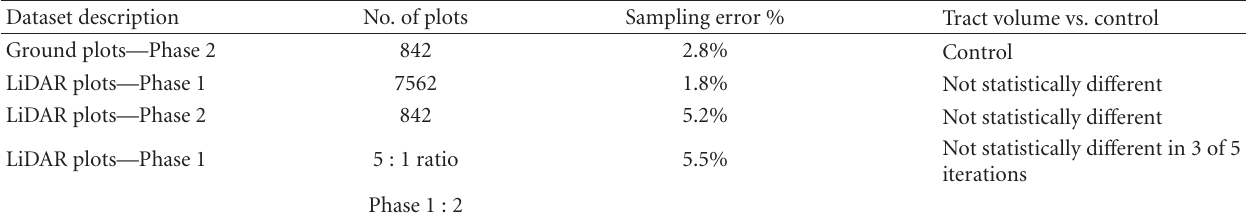
Table 2: Comparison of single-tree, single-phase, volume predictions from LiDAR data using 0.02 ha circular plots on 10 443ha of pine plantations with ground plot volume estimates, where sampling error was half the (1 − α ) confidence interval expressed as a percentage of the